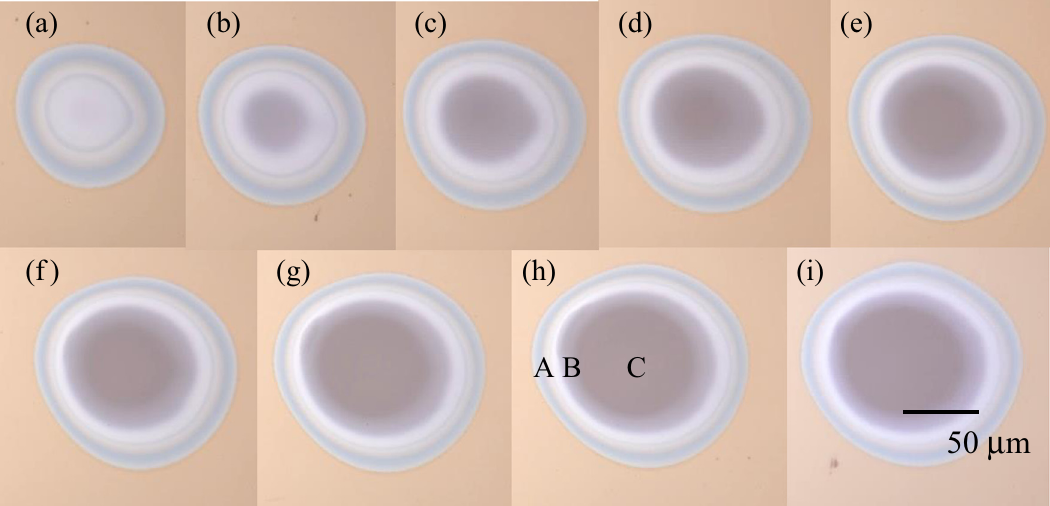
Figure 10: Fs laser removal of ITO on glass from 90 to 620 μ J. Di ff erent degrees of modi fi cation/ablation occurred because of the Gaussian pro fi le of the laser beam. ( a ) 90 μ J, ( b ) 130 μ J, ( c ) 180 μ J, ( d ) 240 μ J, ( e ) 310 μ J, ( f ) 380 μ J, ( g ) 500 μ J, ( h ) 590 μ J, ( i ) 620 μ